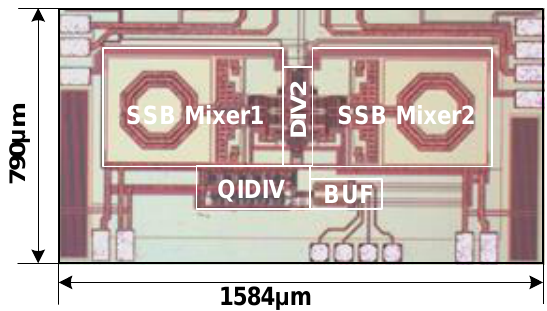
Figure 13. Micrograph of the proposed post synthesis circuit.